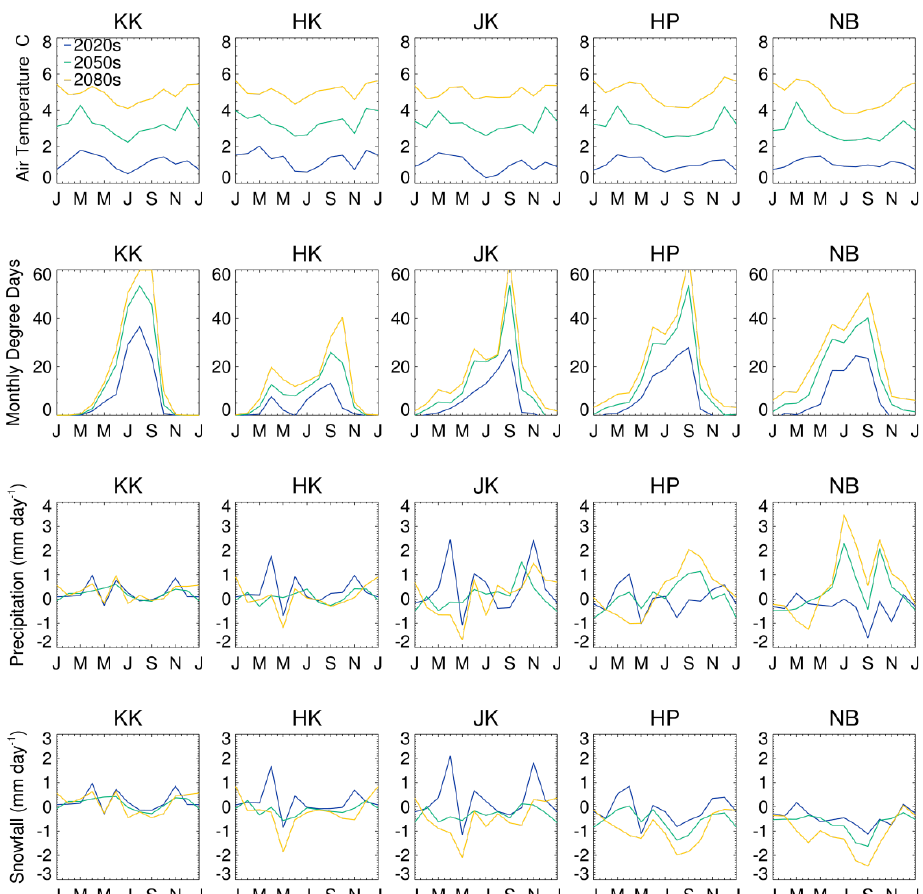
Figure 9. Thirty-year mean climatologies of air temperature, PDDs, precipitation and snowfall for the five sub-regions defined in this study from the downscaled ECHAM5 A1B scenario. Shown are 30yr climatologies for the 2020s (blue), 2050s (green) and 2080s (yellow) anomalised to 1992–2008. The regions are Hindu Kush (HK), Karakoram (KK), Jammu–Kashmir (JK), Himachal Pradesh, Uttarakhand and West Nepal (HP) and East Nepal and Bhutan (NB).